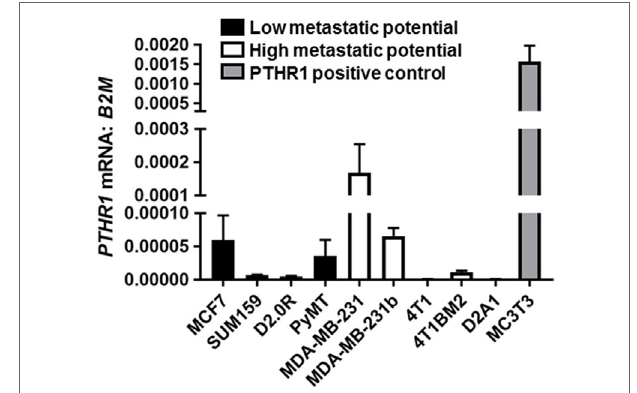
FigUre 1 | PTHR1 is expressed by breast cancer cells. PTHR1 mRNA levels in human breast cancer cell lines {MCF7, SUM159, MDA-MB-231, MDA-MB-231b [bone metastatic clone (25, 26)]}, mouse mammary carcinoma cell lines {D2.0R, PyMT, 4T1, 4T1BM2 [bone metastatic clone (27)], D2A1}, classified according to metastatic potential, and PTHR1/ cyclic AMP responsive MC3T3-E1 cells. mRNA levels were normalized to β -2-microglobulin ( B2M ) housekeeping gene. Graphs = mean + SE. n = 3 replicates from independent